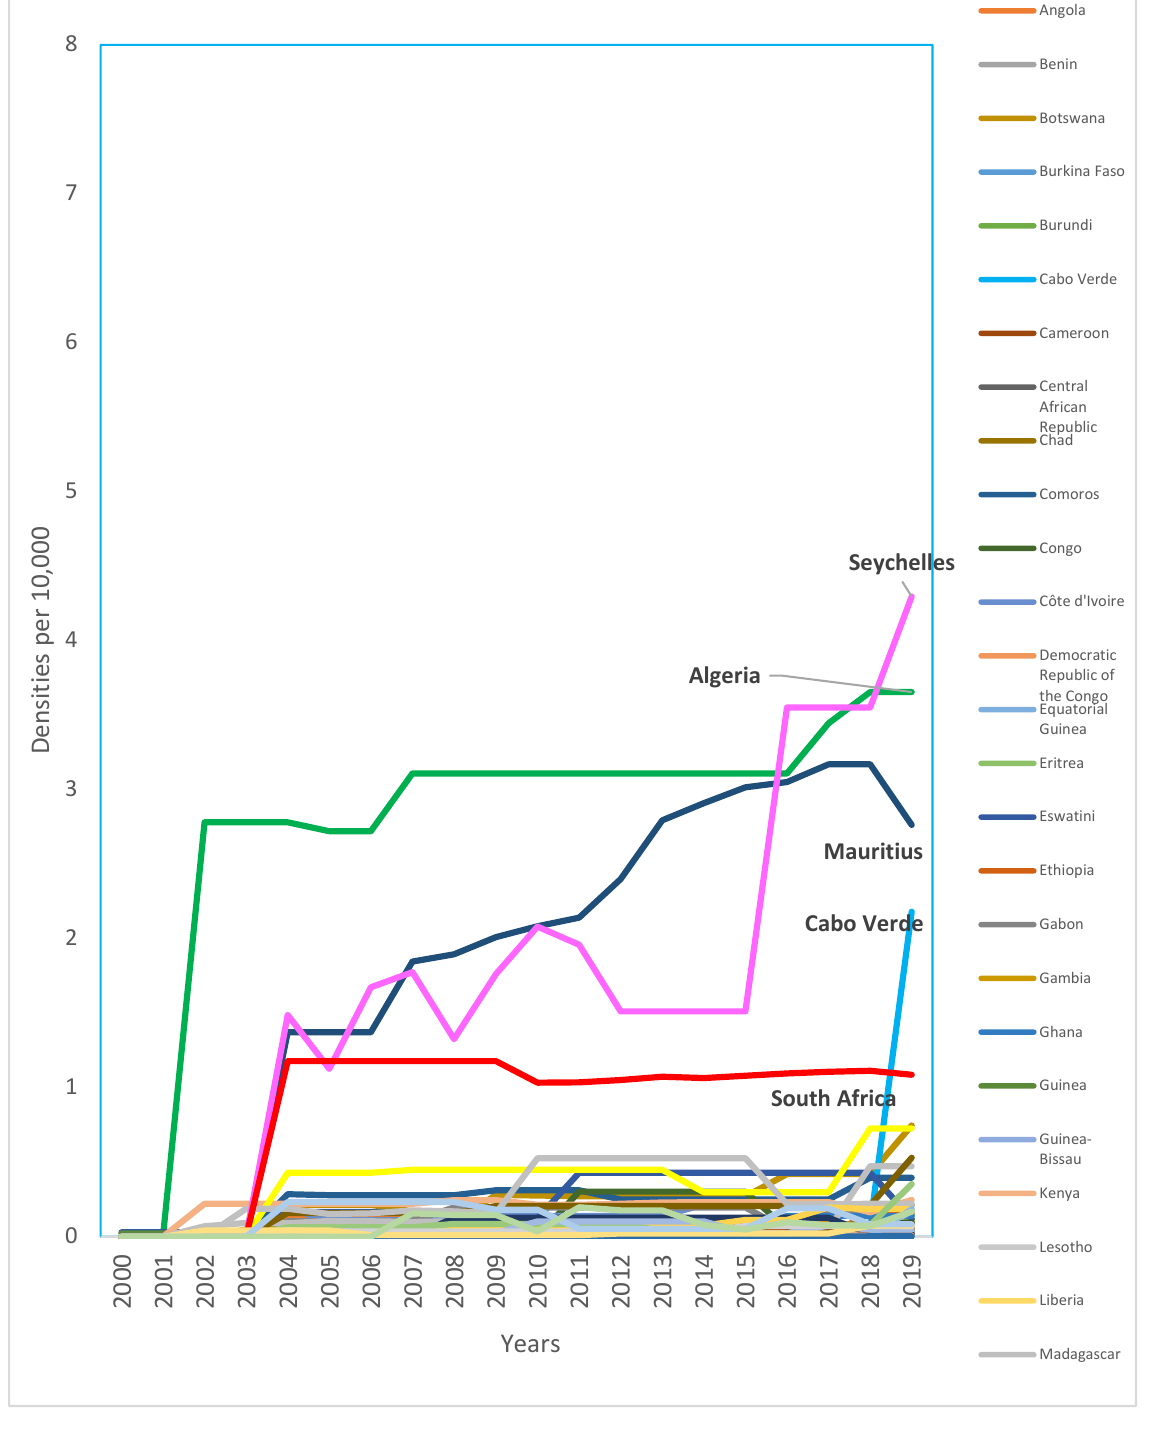
Figure 1. Trends in density of dentists per 10,000 population for the AFR, 2000-2019 (Appendix D). Source: The workforce data are based on the latest available data in the NHWA data platform as of 31 March 2021, apart from the data for 2019, which used a combination of the latest available data from the NHWA data platform and King’s College London survey. Countries with the highest densities were named in the plot and highlighted in bold.